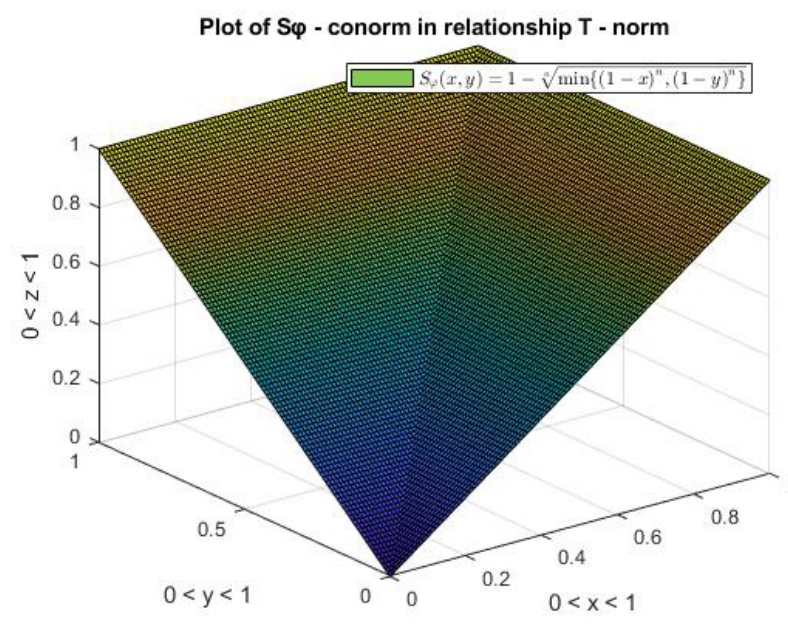
Figure 5. S-conorm generated from S ( x , y ) = 1 − T ( 1 − x ,1 − y ) using an automorphism